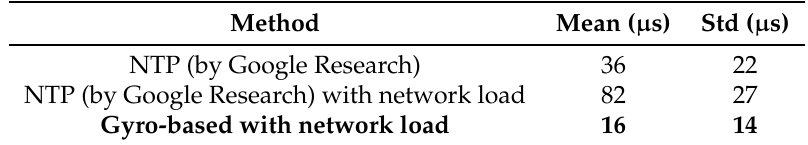
Table 2. A comparison of the performance of Network Time Protocol (NTP)-based and gyroscope- based clock synchronization algorithms performance for synchronous image capture on